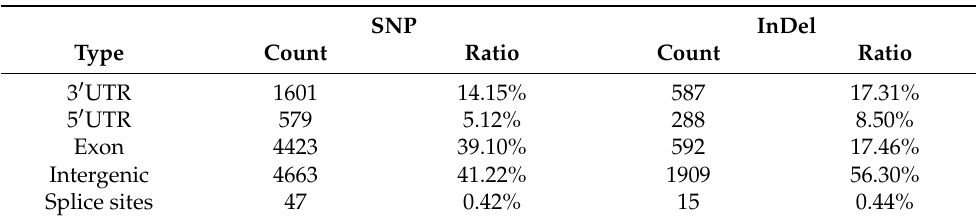
Table 1. Region-wise distribution of single-nucleotide polymorphisms (SNPs) and insertion and deletions (InDels) in Kerria lacca .